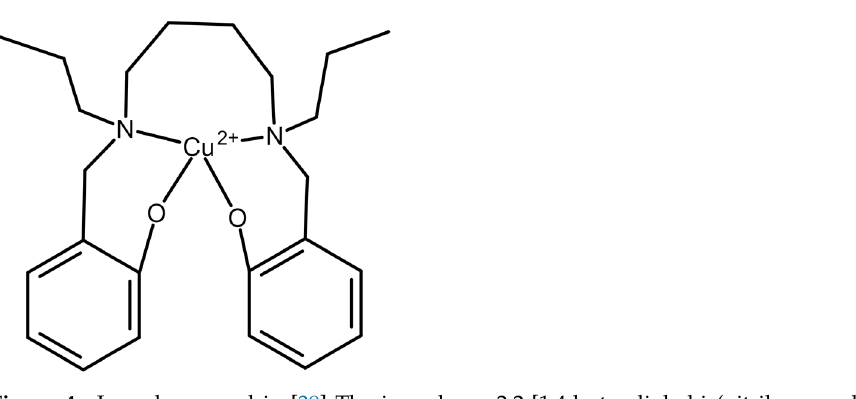
Figure 4. Ionophore used in [39] The ionophore, 2,2-[1,4-butandiyle bis(nitrilo